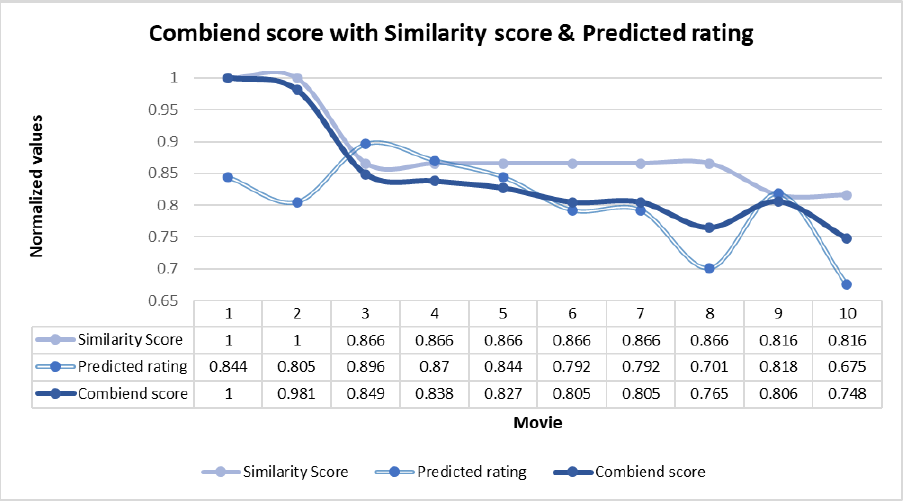
Figure 6. Relation between combined score and similarity score.